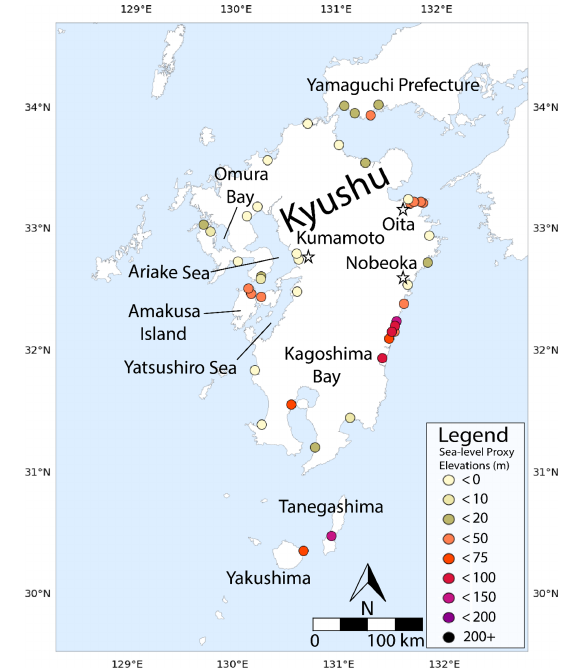
Figure 10. Sea-level elevation proxies in Kyushu and Yamaguchi. Sea-level indicators (circles) with elevation range indicated by color (see legend). Reference cities are indicated by